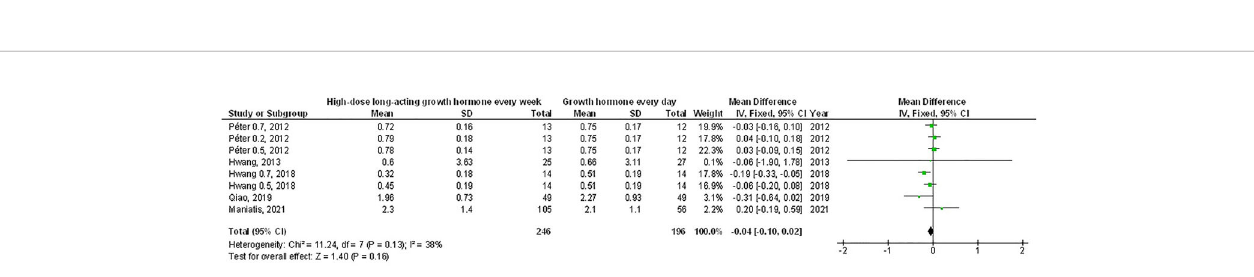
FIGURE 3 | Forest plot of the change in height standard deviation scores chronological age in long-acting growth hormone replacement therapy compared to daily growth hormone.